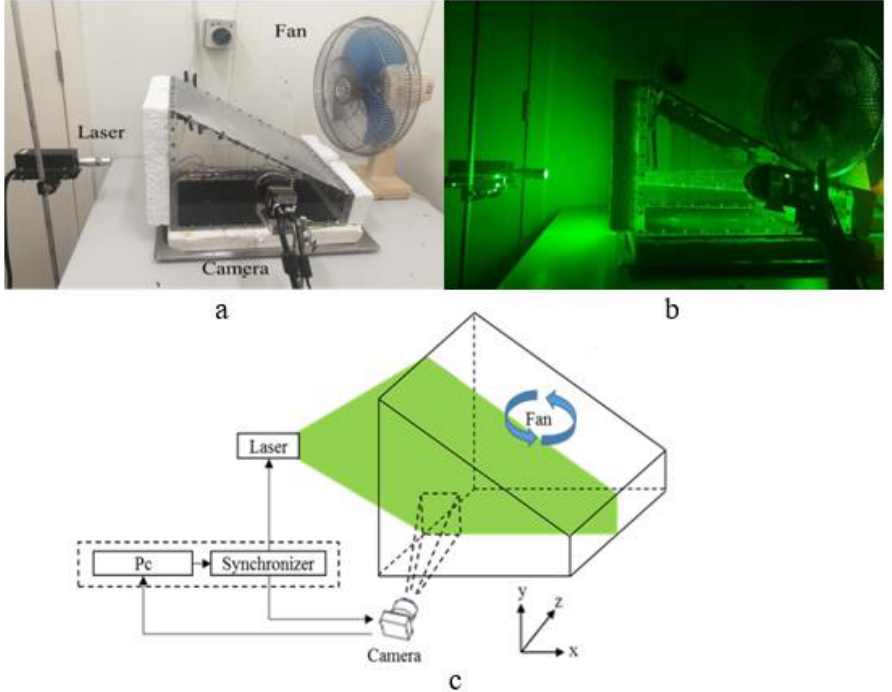
Figure 7. ( a ) Experimental set up ( b ) Laser imaging; and ( c ) Experimental schematic.